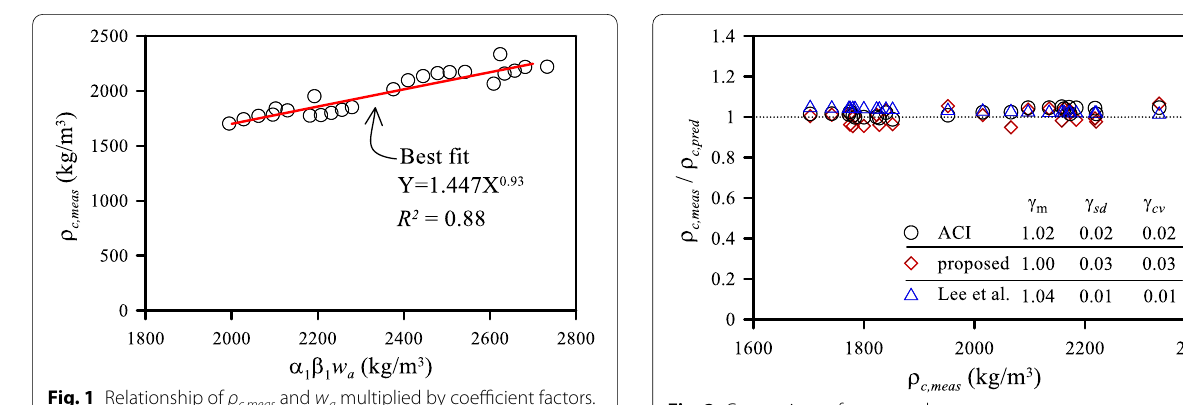
Fig. 2 Comparison of ρ c,meas and ρ c,pred